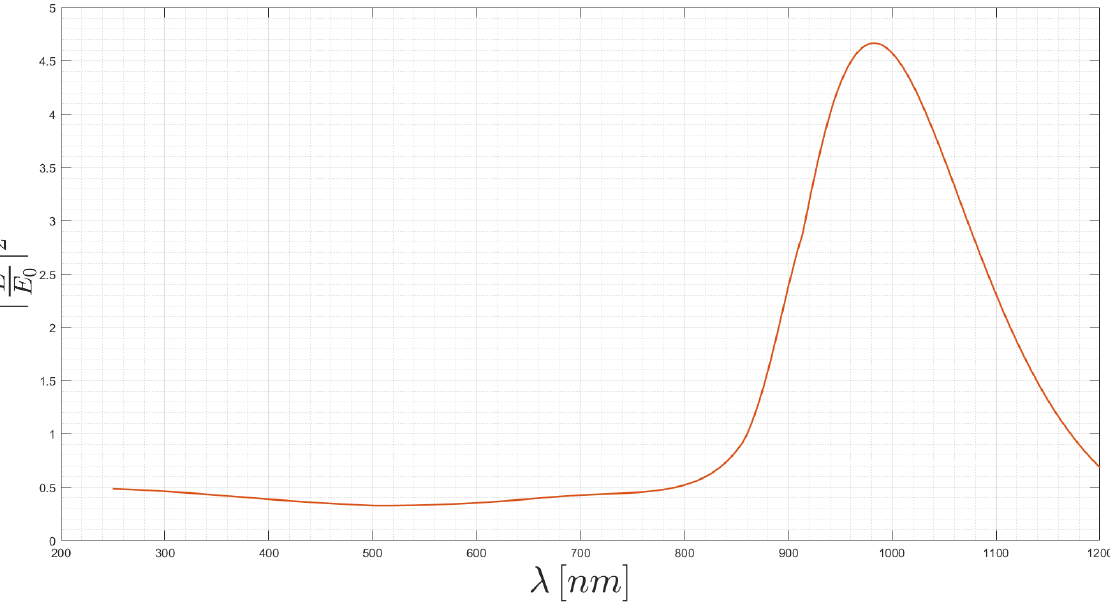
Figure 11. Optical response of an air–gold–quartz nanostructure characterized by a 0 = 0.3µm, d = 120nm, t = 50nm and t sub =